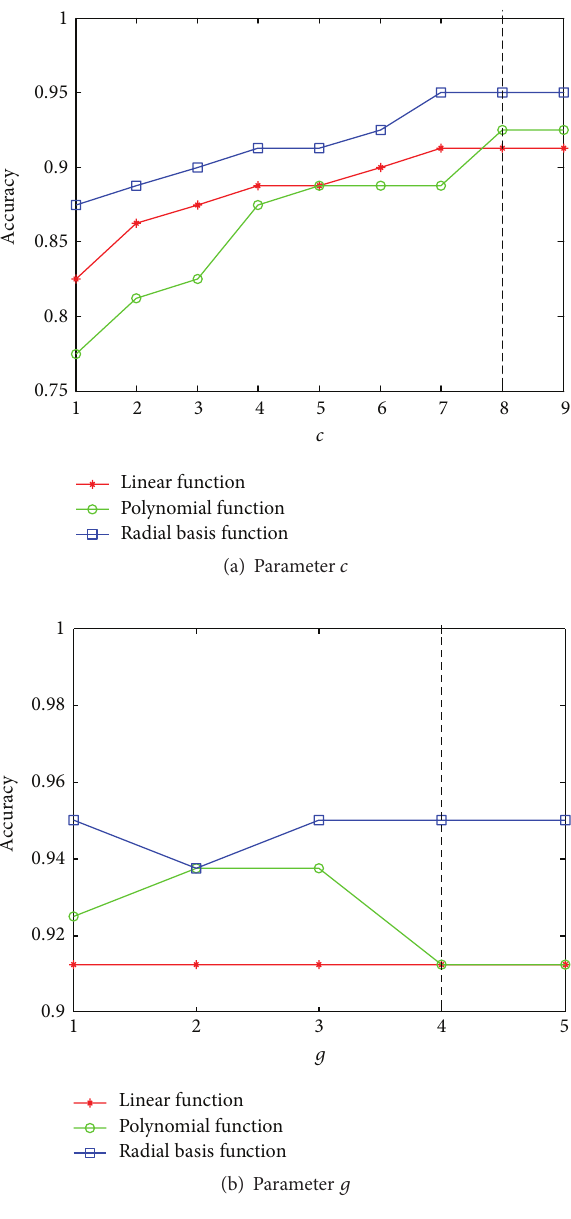
Figure 11: Classification accuracy of the three SVM models using different parameter values in the data